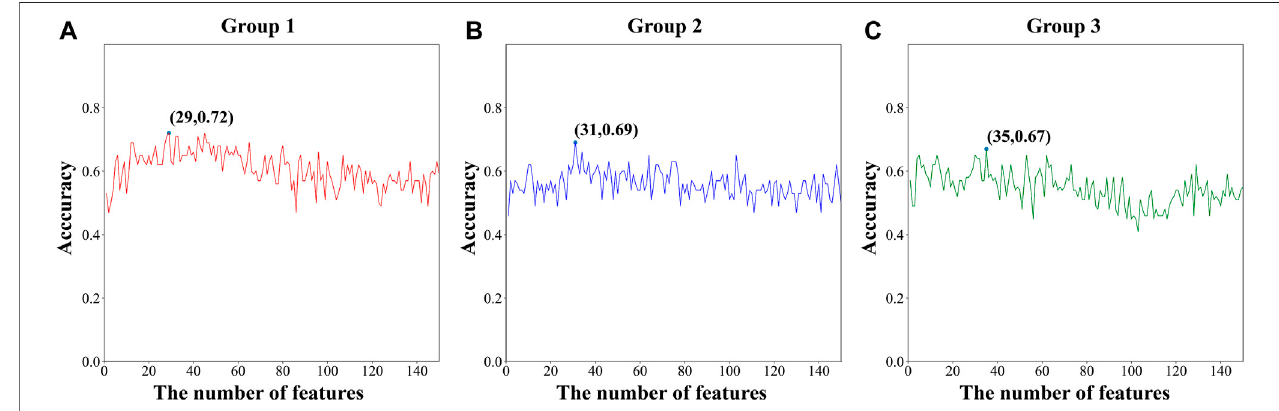
FIGURE 2 | The ACC of different feature numbers during the sequential forward selection process of three sub-datasets (Group 1, Group 2, Group 3).